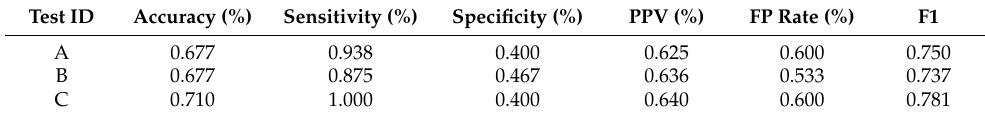
Table 7. Summary of automatically generated decision tree metrics for JSRT images.